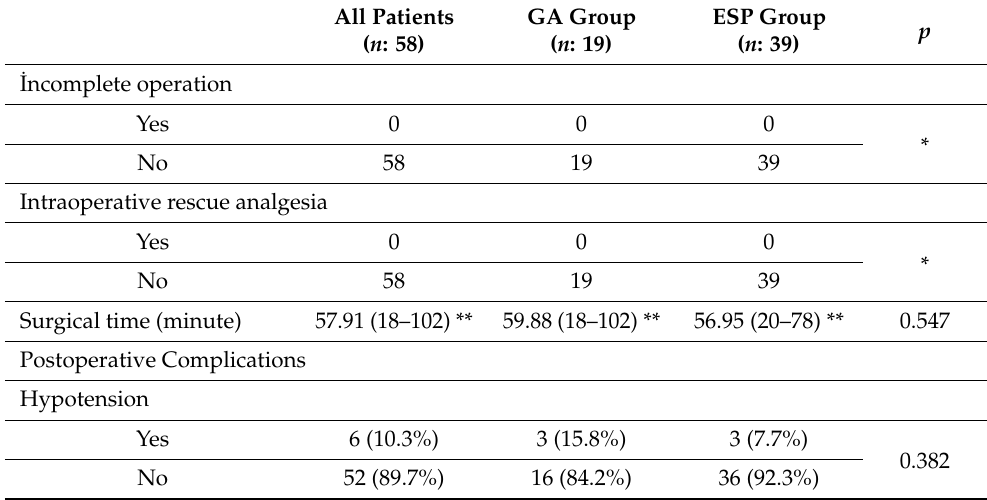
Figure 2. Vertebral levels and number of percutaneous balloon kyphoplasty. Table 2. Comparison of anesthesia methods with intraoperative and postoperative metrics. All